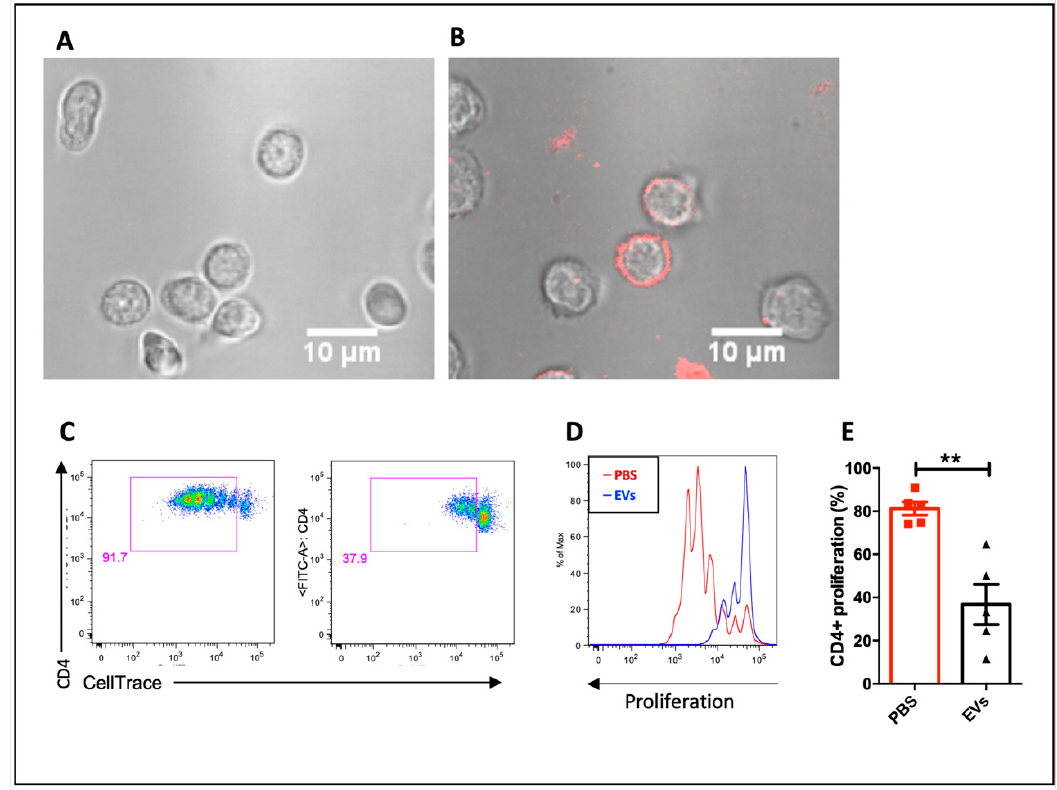
Figure 2. E ff ects of MSC-EVs on lymphocytes proliferation: incorporation of PKH26-labeled MSC-EVs by purified naive CD4 + cells using confocal microscopy, before ( A ) and 15 h after the addition of EVs ( B ). MSC-EVs e ff ect on total splenocytes proliferation when stimulated by anti-CD3 and anti-CD28 ( C – E ). Data are representative of 5 independent experiments (** p < 0.01).